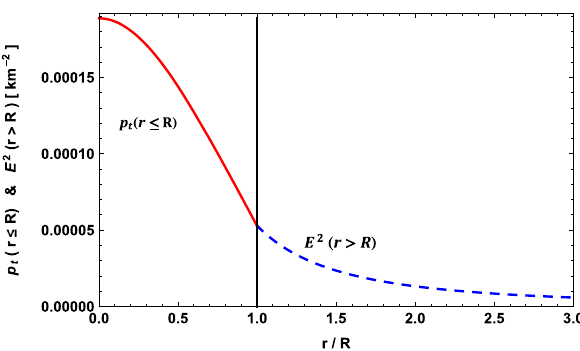
Fig. 9 Matching of p t ( r ≤ R ) with E 2 ( r > R ) at the surface of the